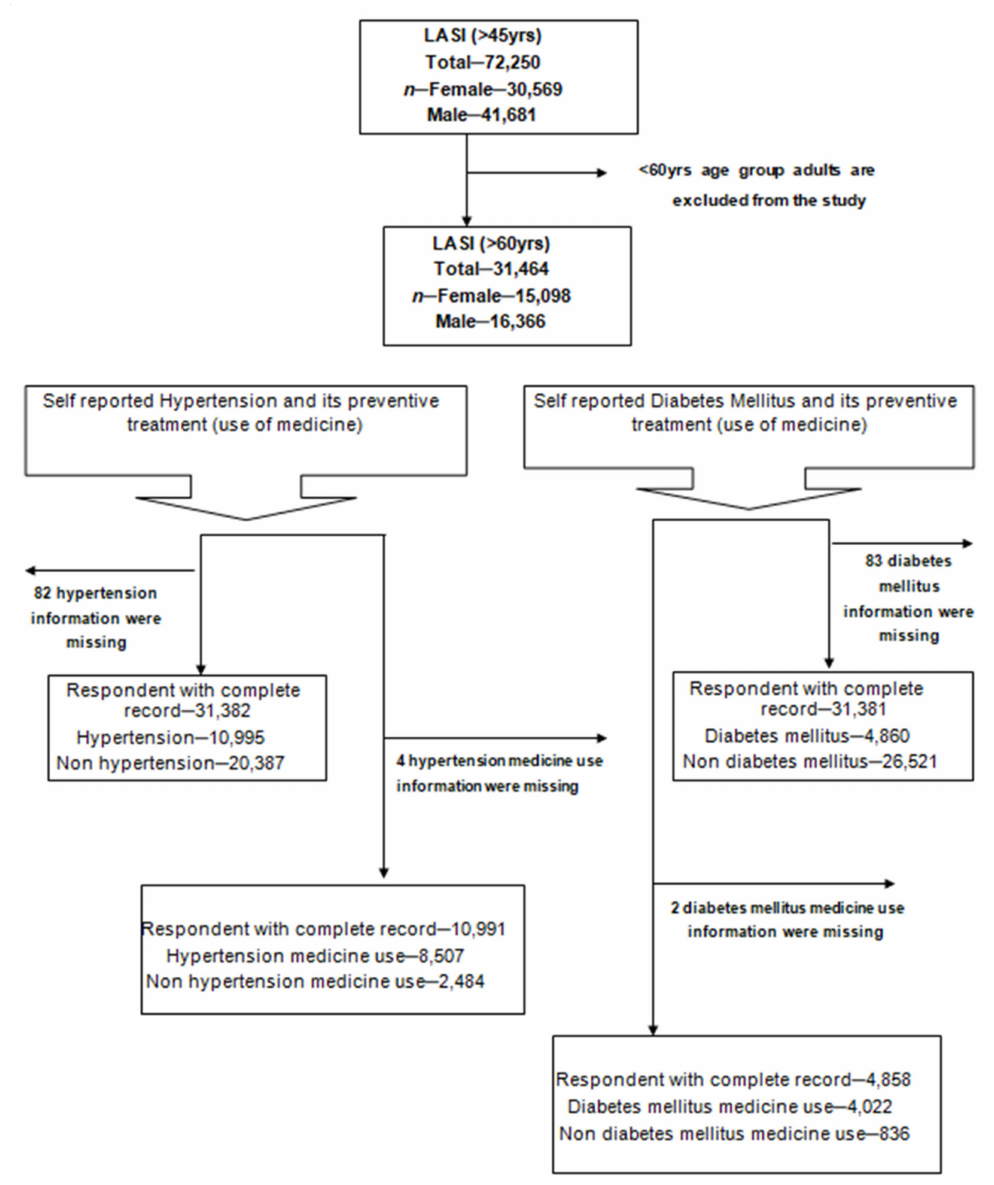
Figure 1. Schematic figure explaining sample extraction from LASI